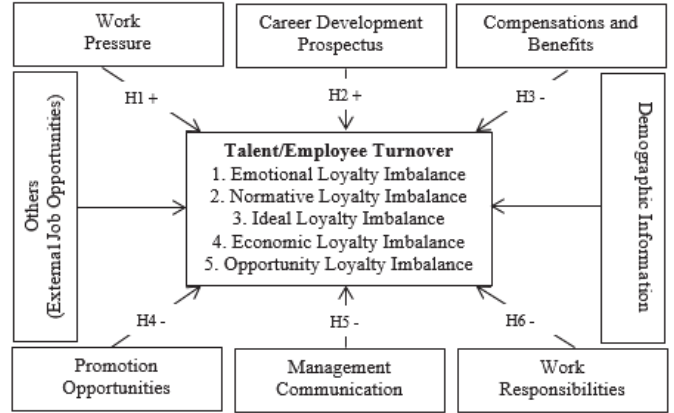
Fig. 1. Conceptual